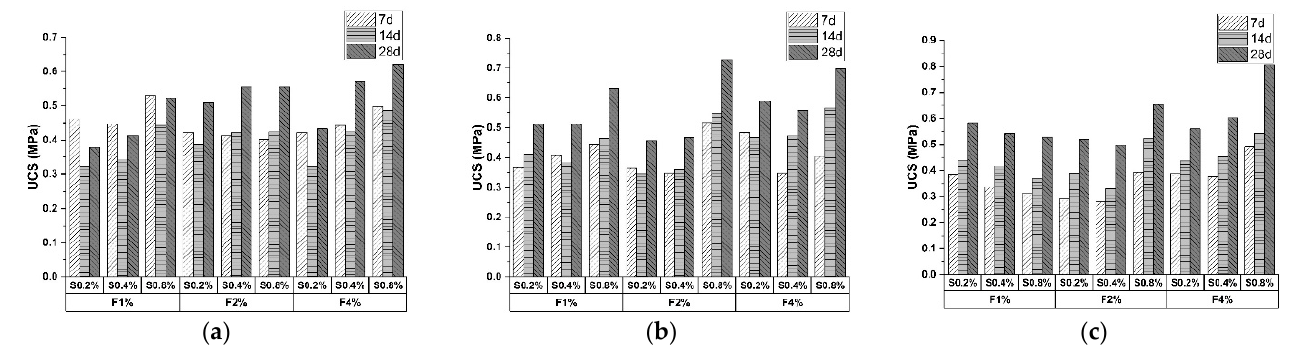
Figure 2. Unconfined compressive strength of 10% cement specimen with ( a ) 10% C&D waste; ( b ) 20% C&D waste; ( c ) 30% C&D waste (Note: S represents sodium sulfate; F represents polypropylene fiber).